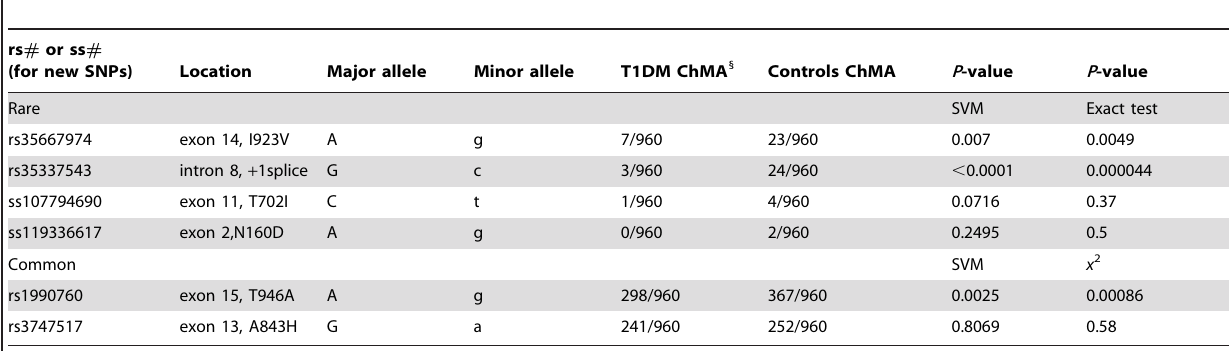
rs # or ss # (for new